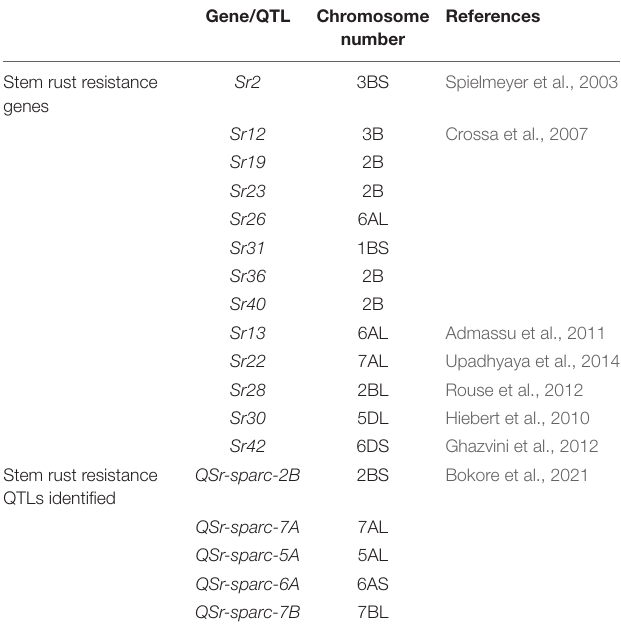
TABLE 4 | Stem rust resistance genes and QTLs mapped on various T. aestivum chromosomes. Gene/QTL Chromosome